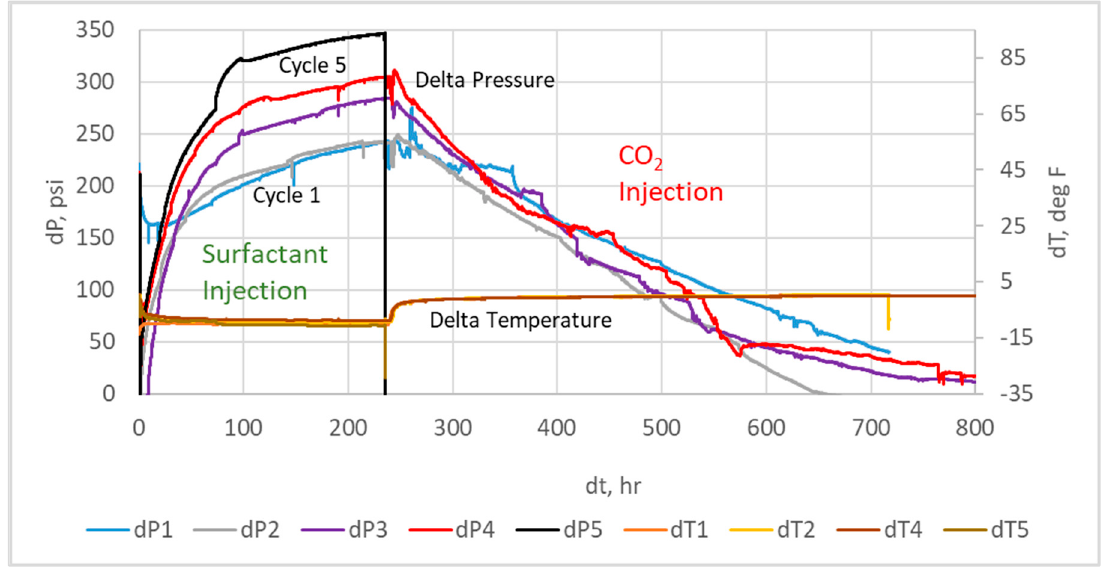
Figure 8. Transient pressures and temperatures for the first five SAG cycles. dP1 corresponds to slug 1, dP2 to slug 2, and so on.